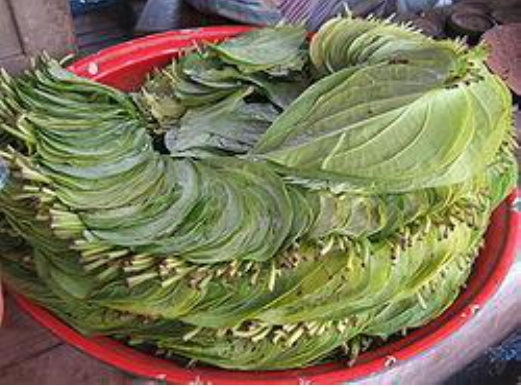
Figure 7. Harvested and ready-for-sale leaves of the plant betel pepper (Piper